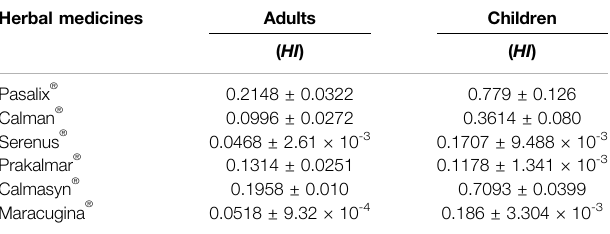
TABLE 8 | Total hazard index ( HI ) of the elements for adults and